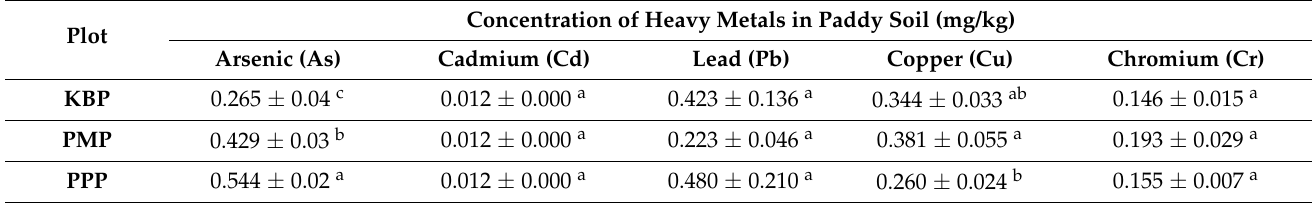
Table 2. Concentration of heavy metals in paddy soils collected from Kelantan. Concentration of Heavy Metals in Paddy Soil Plot